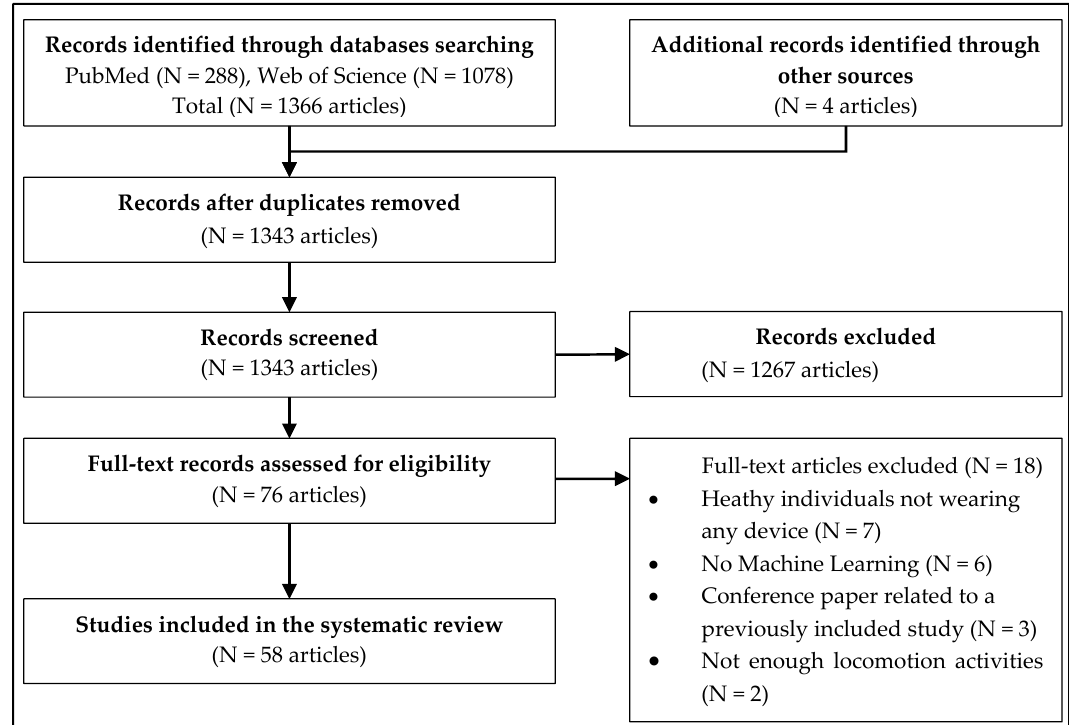
Figure 1. Preferred Reporting Items for Systematic reviews and Meta ‐ Analyses (PRISMA) flow chart of the systematic review.